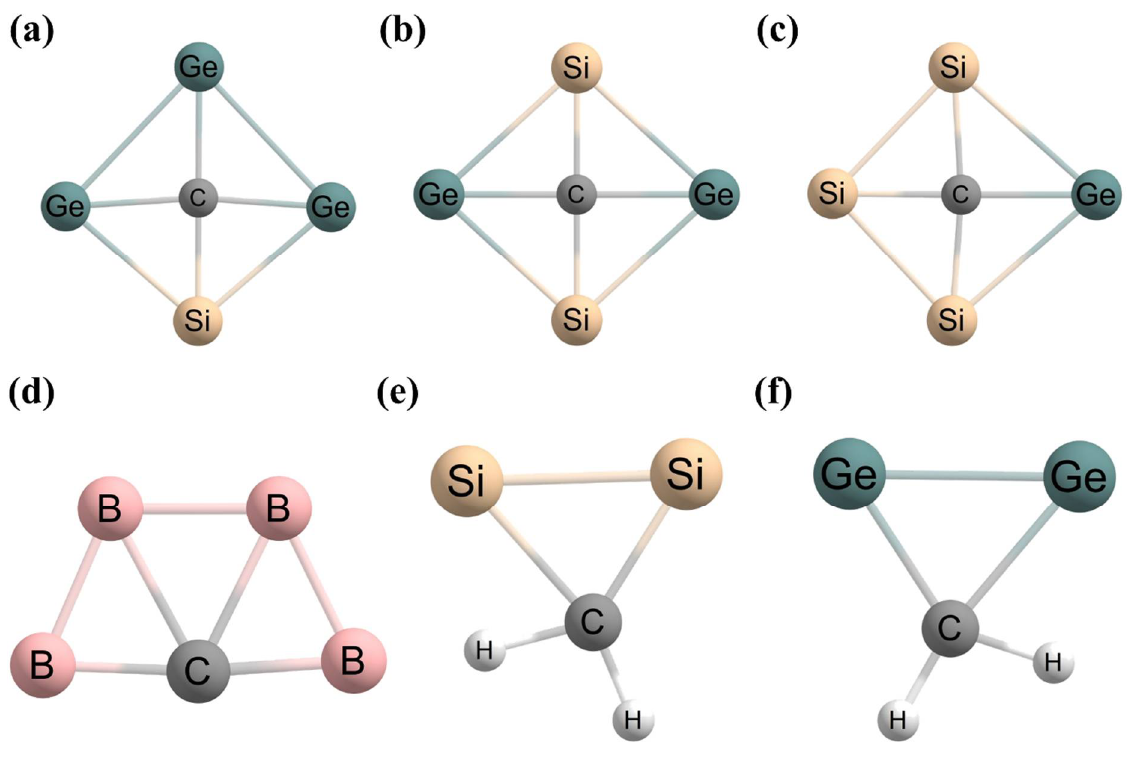
Figure 8. The global minimum structures of ( a ) CSiGe 32+ , ( b ) CSi 2 Ge 22+ , ( c ) CSi 3 Ge 2+ , and ( d ) CB 4+ clusters containing a ptC. The local minimum structures of ( e ) Si 2 CH 2 and ( f ) Ge 2 CH 2 molecules.